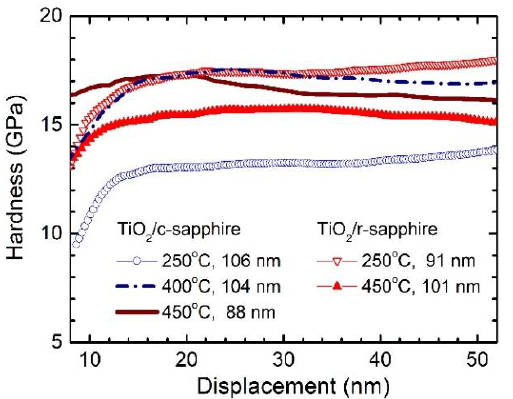
Figure 13. Hardness as a function of tip displacement recorded for TiO 2 films grown at different temperatures on c- and r-sapphire. Growth temperatures and film thicknesses are shown in the figure.